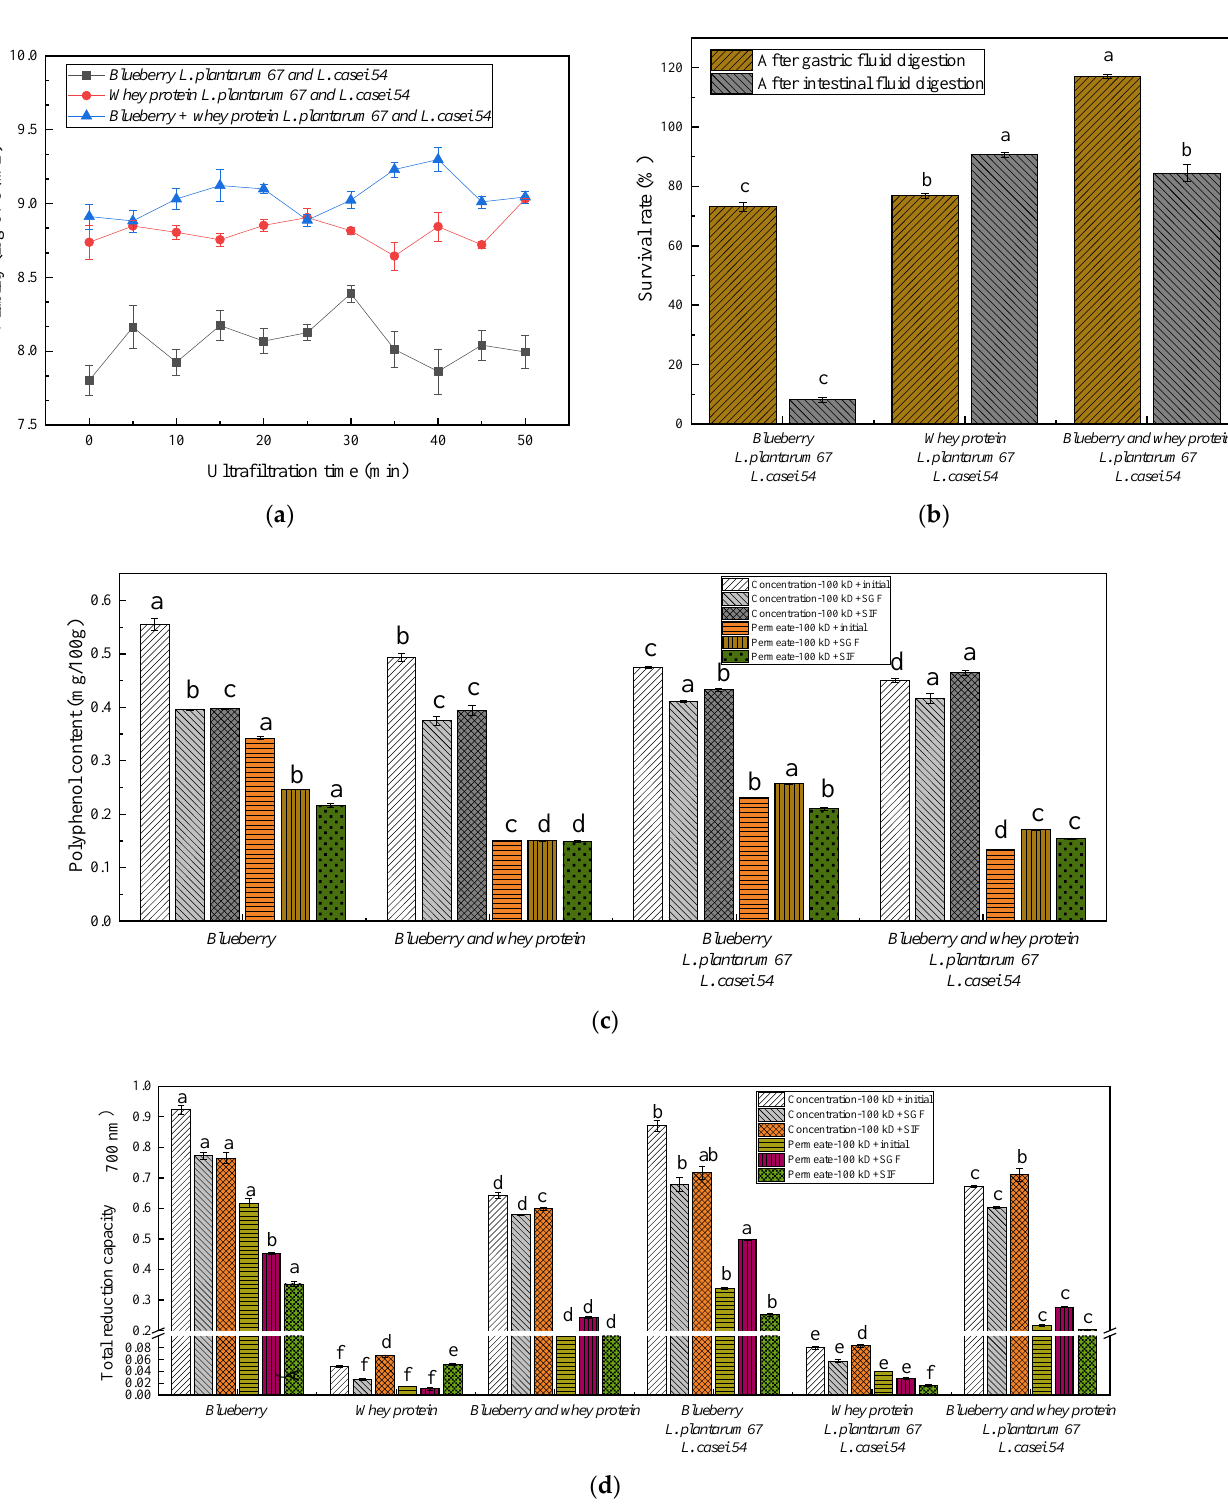
Figure 6. The effect of operation time on the probiotic viability ( a ), the survival of probiotics ( b ), the total phenol content ( c ) and the total reduction capacity ( d ) of products separated by ultrafiltration before and after in vitro gastrointestinal digestion. Different letters within the same column indicate significant differences ( p < 0.05).